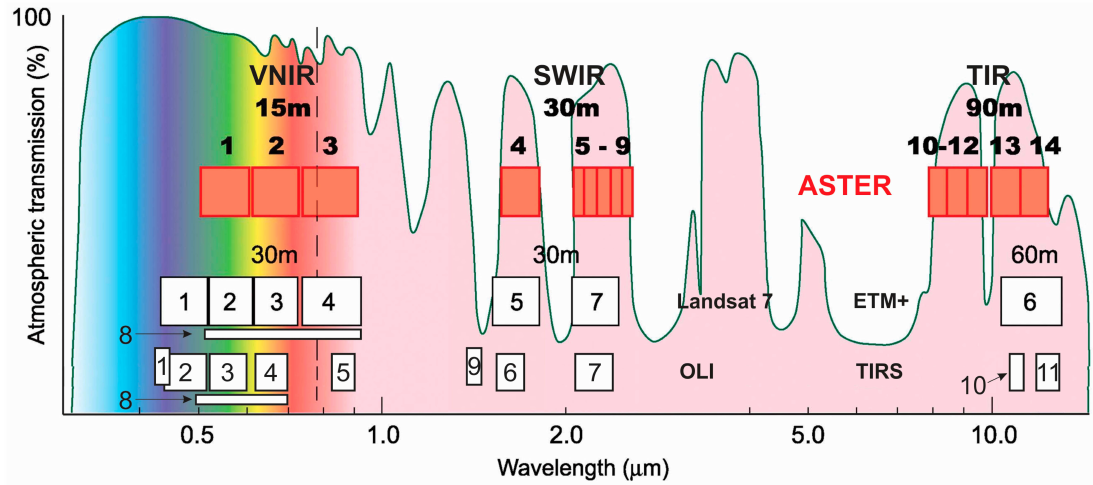
Figure 1. Electromagnetic spectrum comparing ASTER and Landsat (ETM+ and OLI/TIRS) bands. The spatial resolution for bands in the visible and near infrared (VNIR), short-wave infrared (SWIR) and thermal infrared (TIR) are specified for each sensor. The vertical dashed line represents the end of the visible light. Figure based on